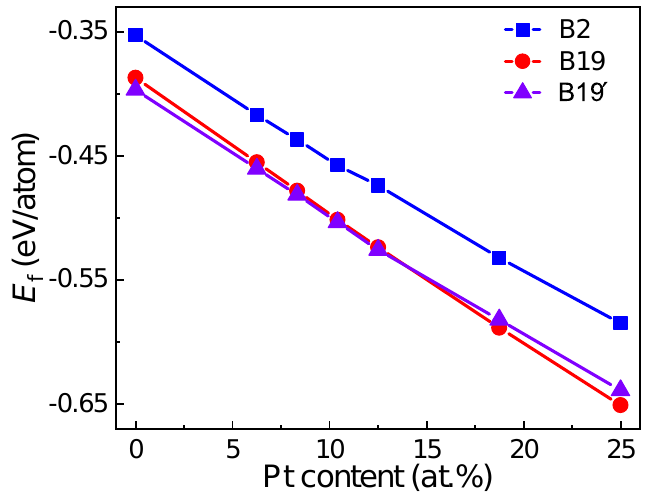
Figure 4. The formation energies, E f of the austenite B2, martensite B19 and B19 (cid:48) phases as a function of Pt content in ternary Ti 50 Ni 50 − x Pt x alloys.